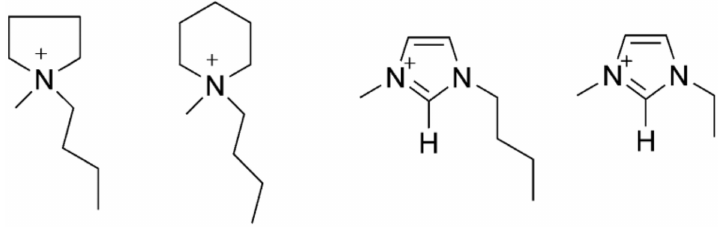
Figure 3. Structures of some cations of ionic